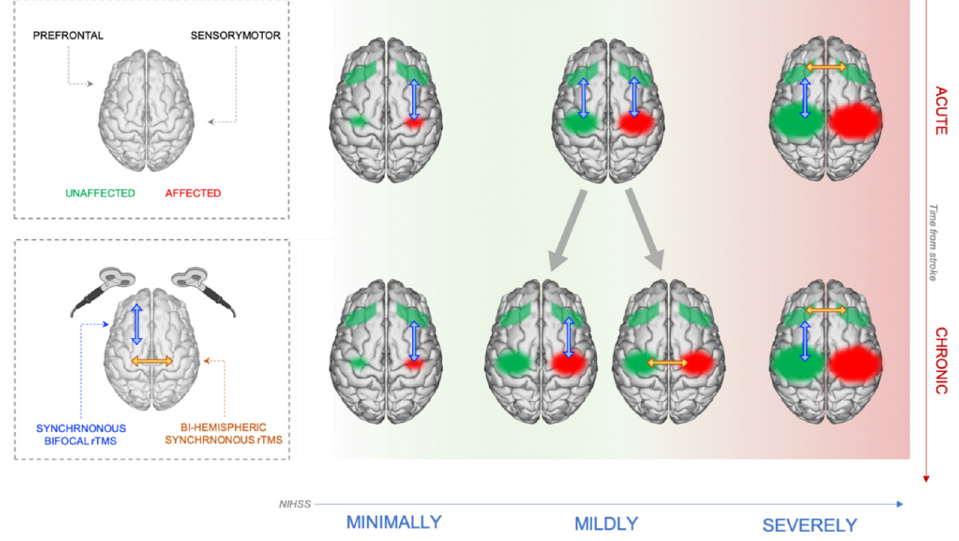
Figure 3. Scheme of the NIBS stimulation protocols developed on the basis of the patient’s individual brain reorganization proposed in the framework.